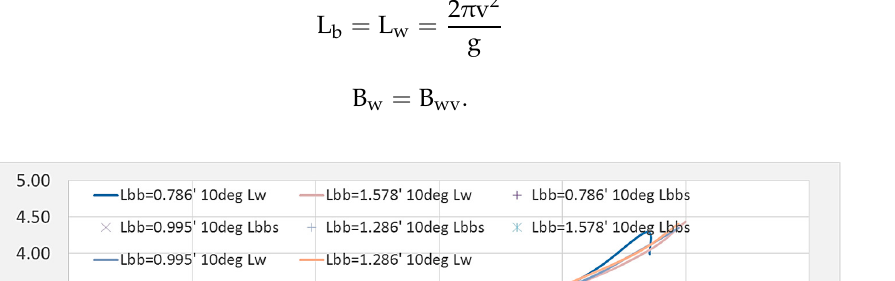
Figure 18. B w for 10° pitch angle.